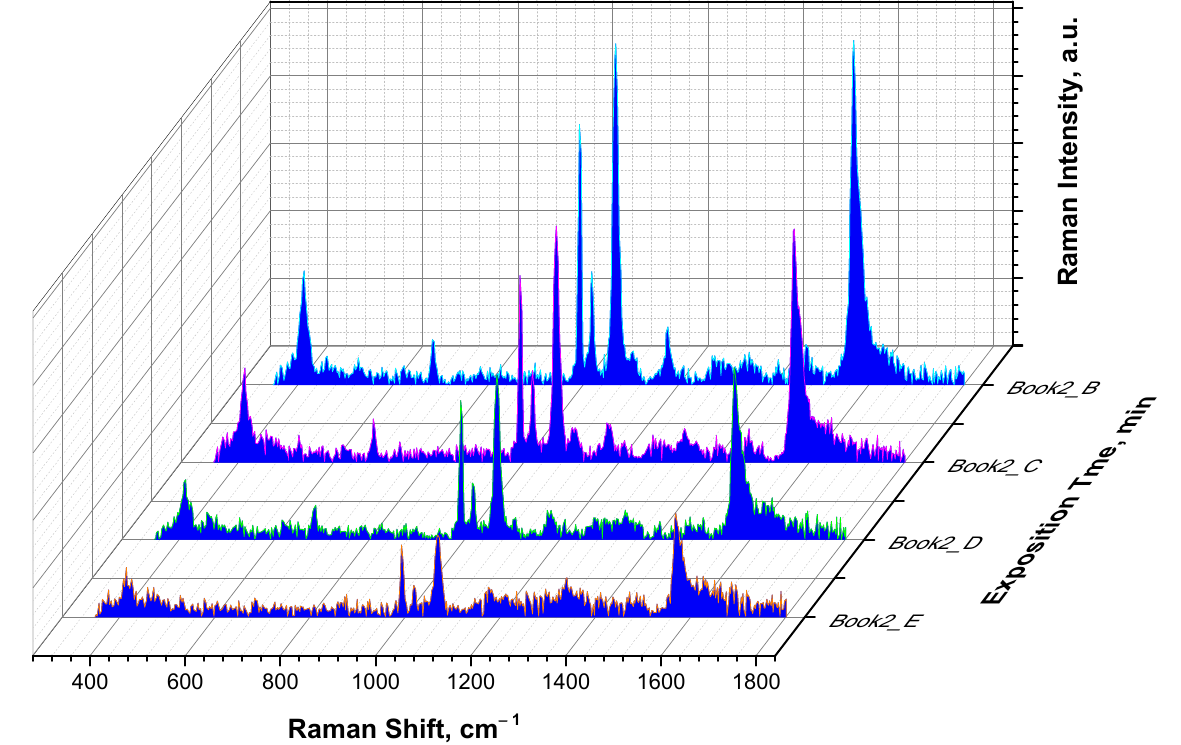
Figure 4. The evolution of the SERS spectra of the 10 µ L drop of the AgNPs/PB- b -PDMAEMA hybrid with 30 µ M of 4-MPBA at different exposure times: 0 min (orange line); 3 min (green line); 6 min (pink line); and 8 min (light blue line).